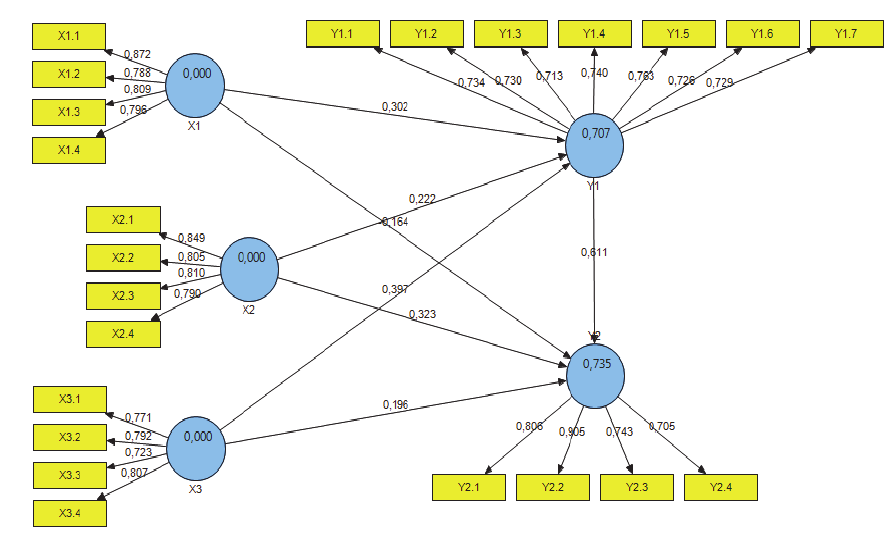
Fig. 2. SEM-PLS Measurement Model (Outer